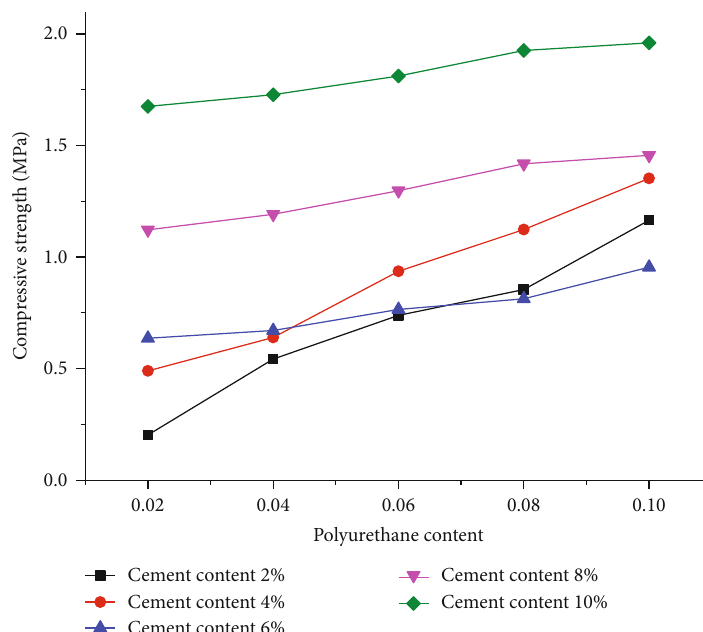
Figure 8: E ff ect of cement and polyurethane content on compressive strength of materials.